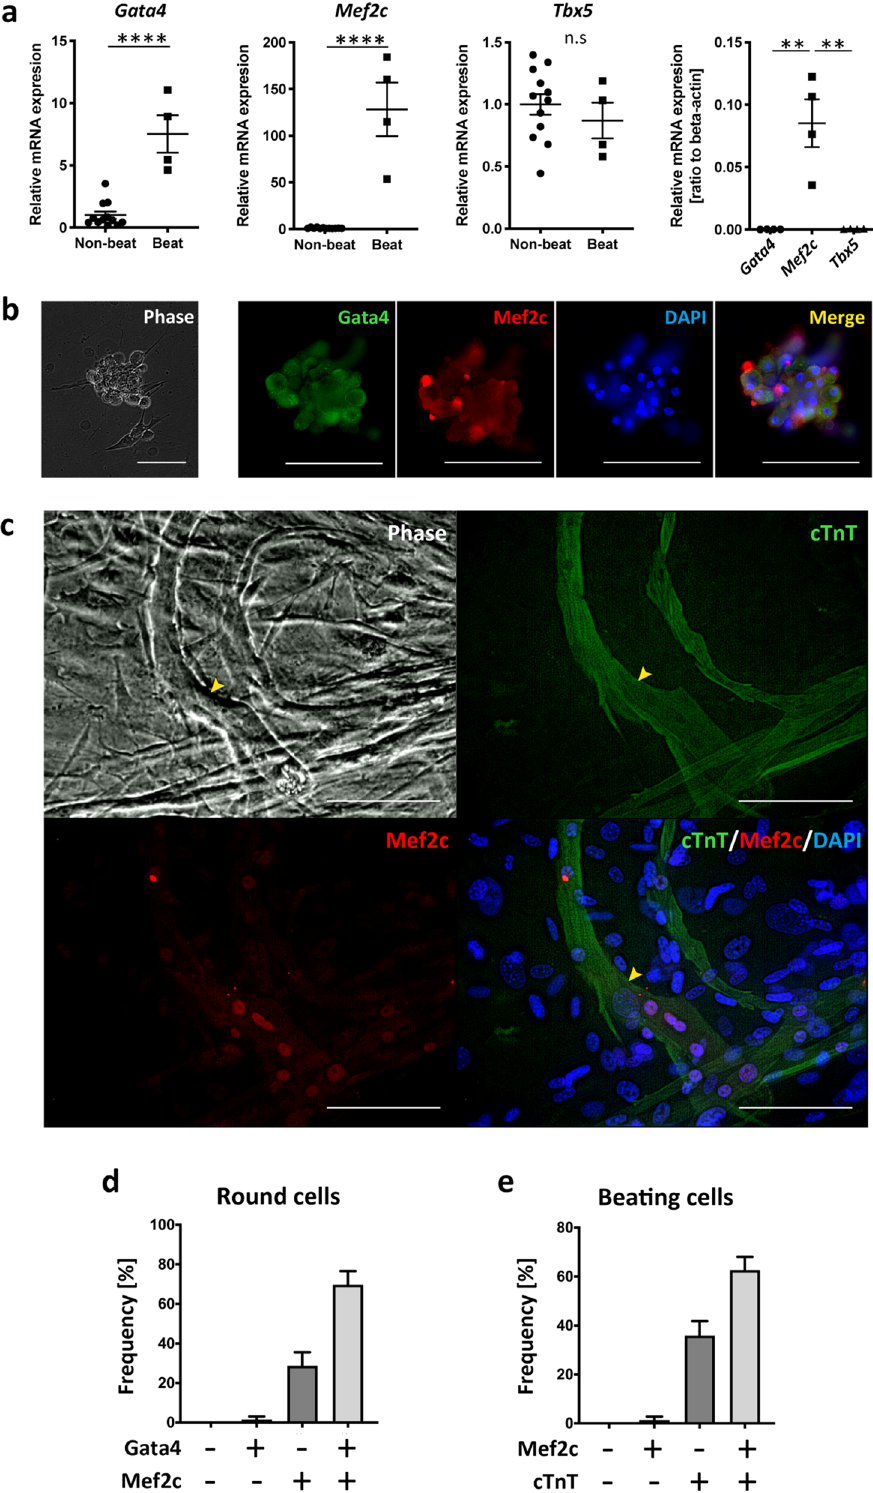
Figure 6. Gata4, Mef2c, and Tbx5 expression in the beating and non-beating groups. ( a ) Left three panels, gene expression levels in the beating and non-beating group. Right panel, gene expression levels in the beating and non-beating group relative to that of β-actin. ( b ) Representative immunofluorescence images of a cluster of round cells expressing Gata4 and Mef2c on day 14. ( c ) Phase-contrast and immunofluorescence images of beating cells expressing cardiac troponin T (cTnT) and Mef2c on day 28. The arrowhead indicates a beating cell. Scale bar, 100 µm. DAPI, 4 ′ ,6-diamidino-2-phenylindole, ** p < 0.01; **** p < 0.0001 by t -test or ANOVA and Tukey’s post hoc test. ( d ) The frequency of round cells expressing Gata4 and Mef2c (10 round cells were examined per experiment, n = 13). ( e ) The frequency of beating cells expressing Mef2c and cTnT (15 beating cells were analysed per experiment, n =